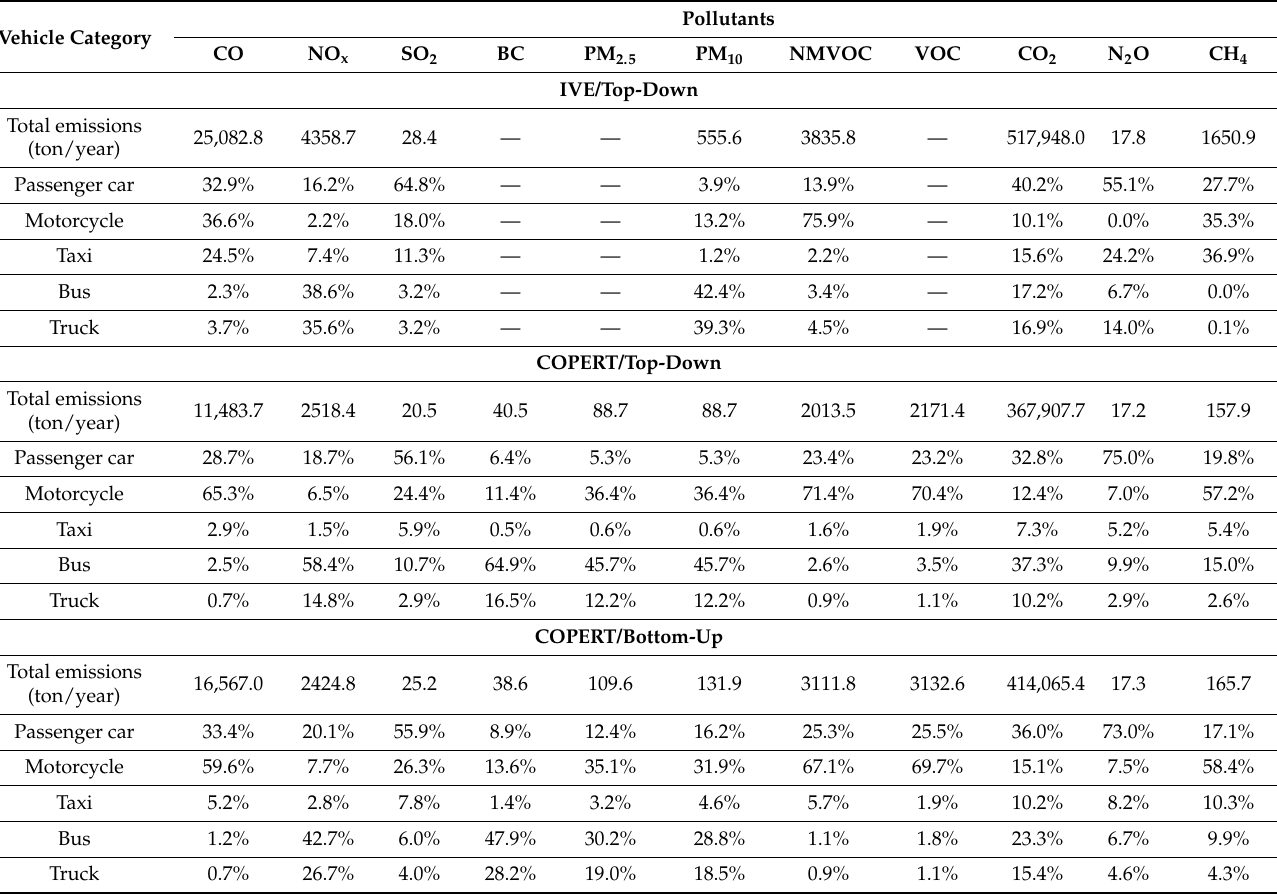
Table 2. Total annual emission fluxes in the city of Manizales for the base year 2017 and contribution by vehicle category. Vehicle Category